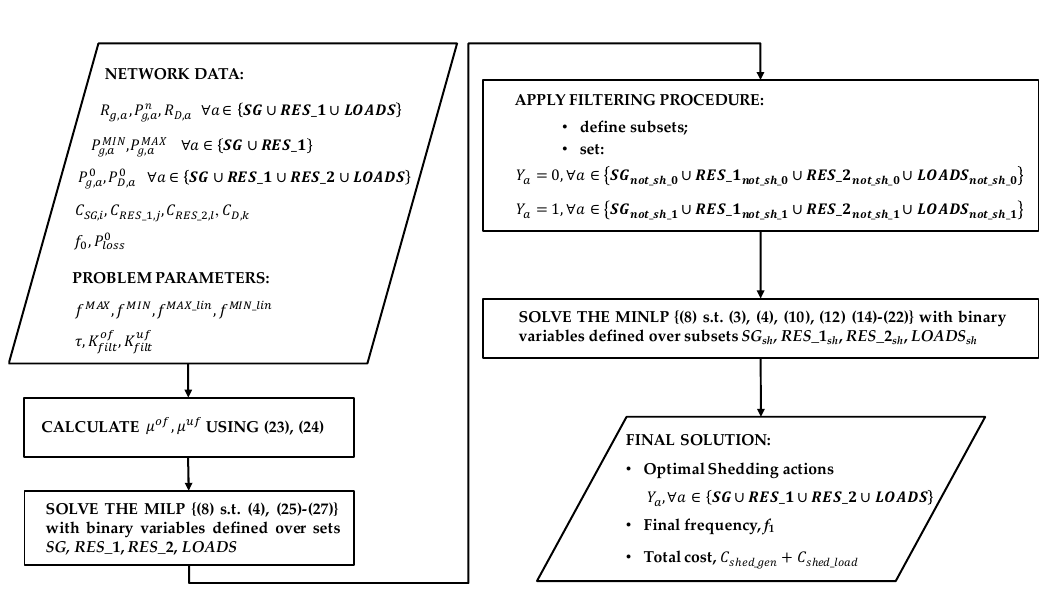
Figure 7. Advanced Optimization Model.